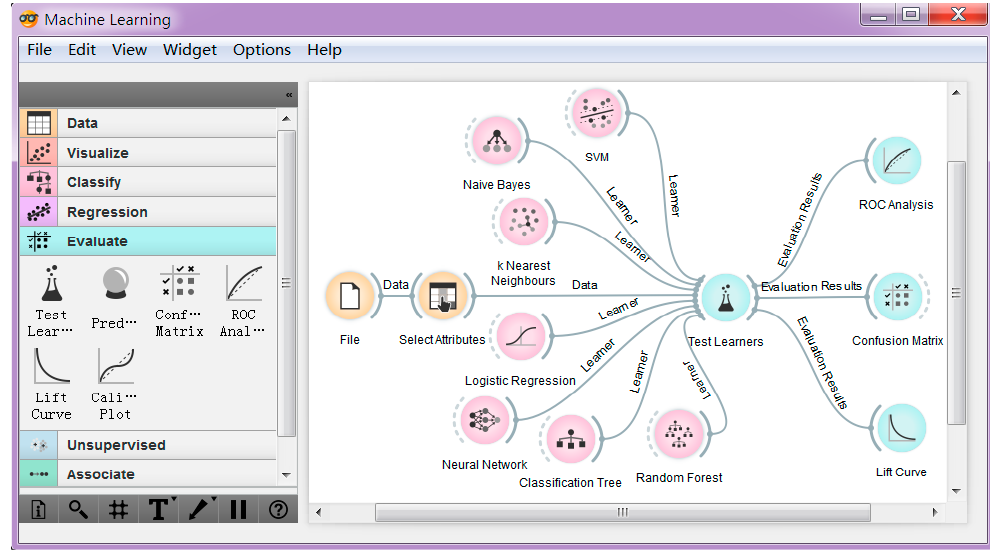
Figure 7. Workflow of the data classification using Orange toolkit.